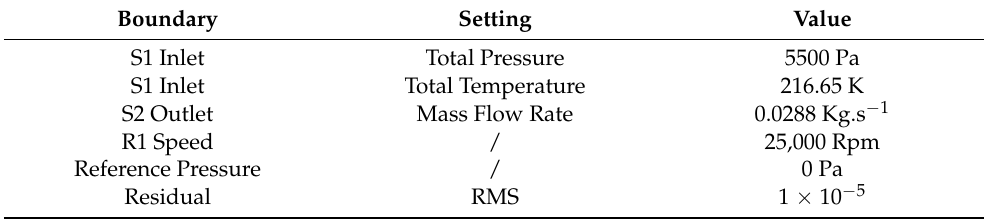
Table 2. Numerical analysis of boundary conditions for MIX-130 fan.